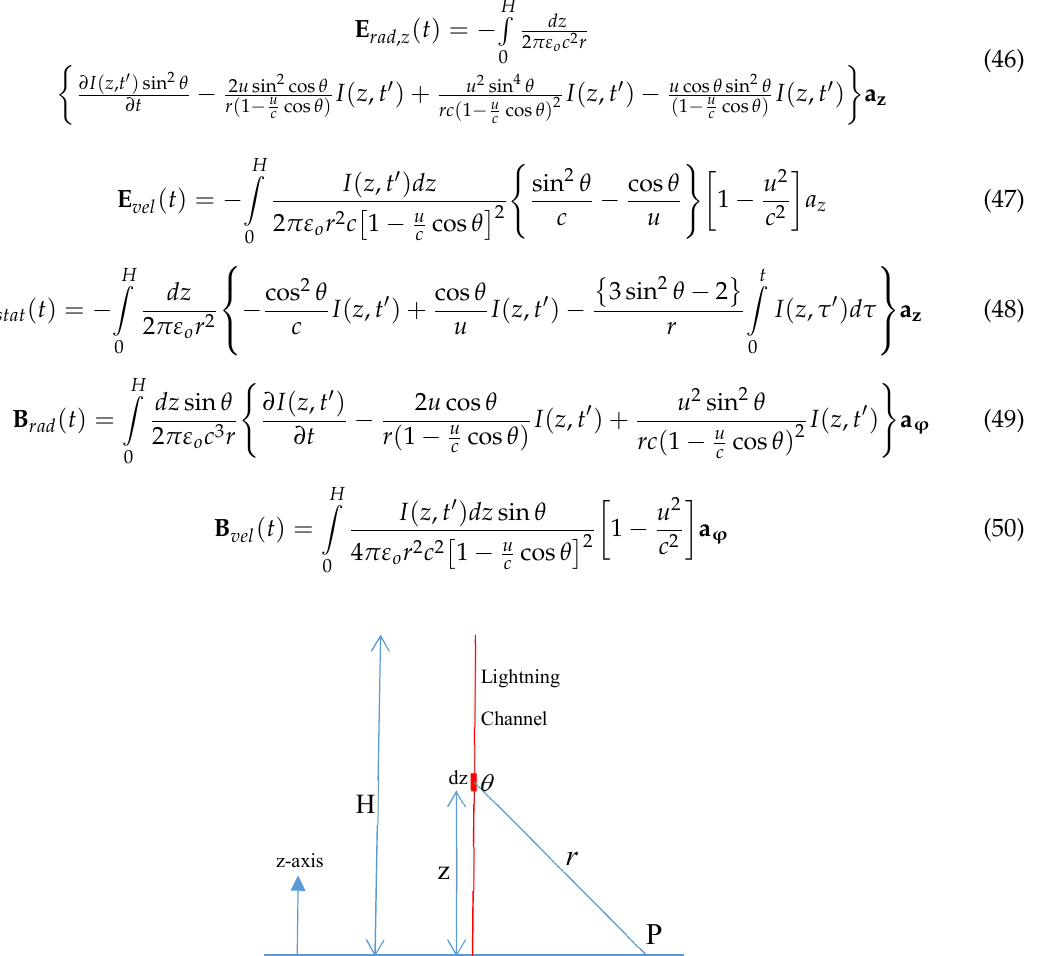
Figure 2. Geometry relevant to the calculation of electromagnetic fields from a return stroke.